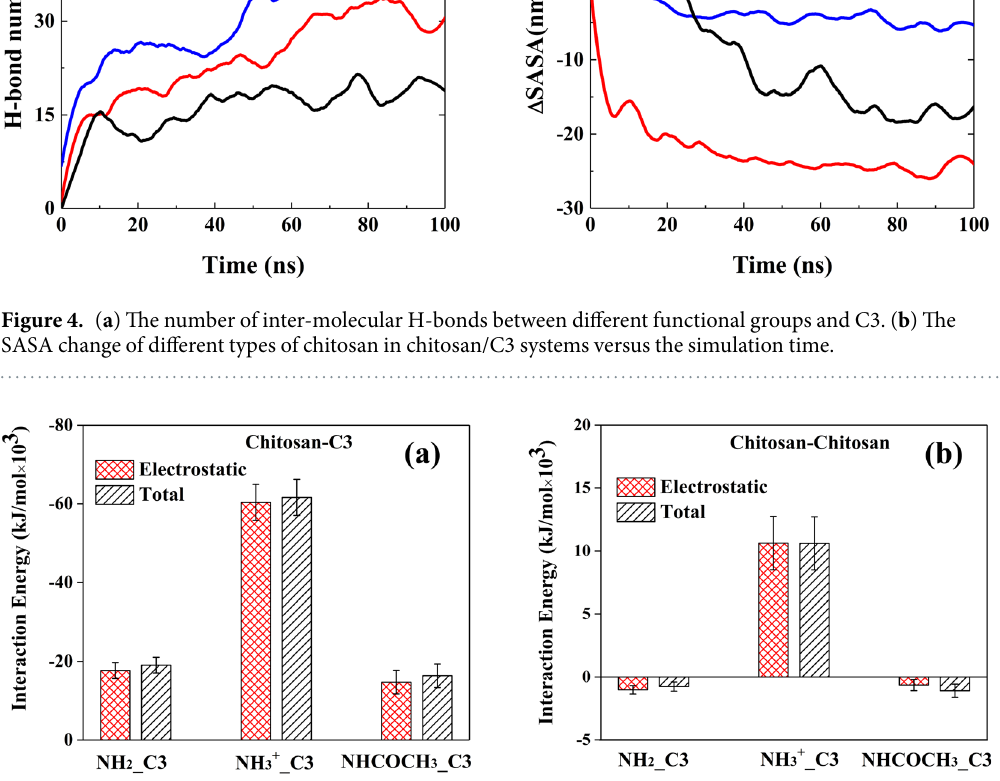
Figure 5. The average electrostatic and total interaction energies of ( a ) Chitosan–C3 and ( b ) Chitosan–chitosan in the systems with the ratio chitosan: C3 = 3:10. Data were taken from the last 50 ns trajectories of the total 100 ns in the MD simulations. The error bars represent the standard deviations of the